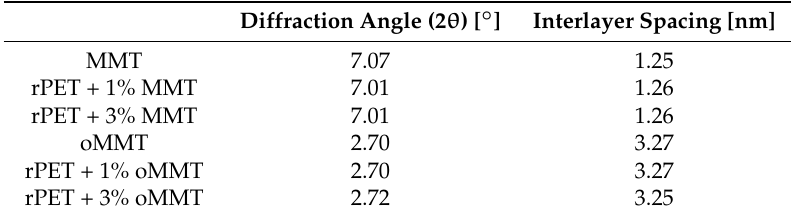
Table 3. Results of wide-angle X-ray diffraction (WAXD)S measurements.